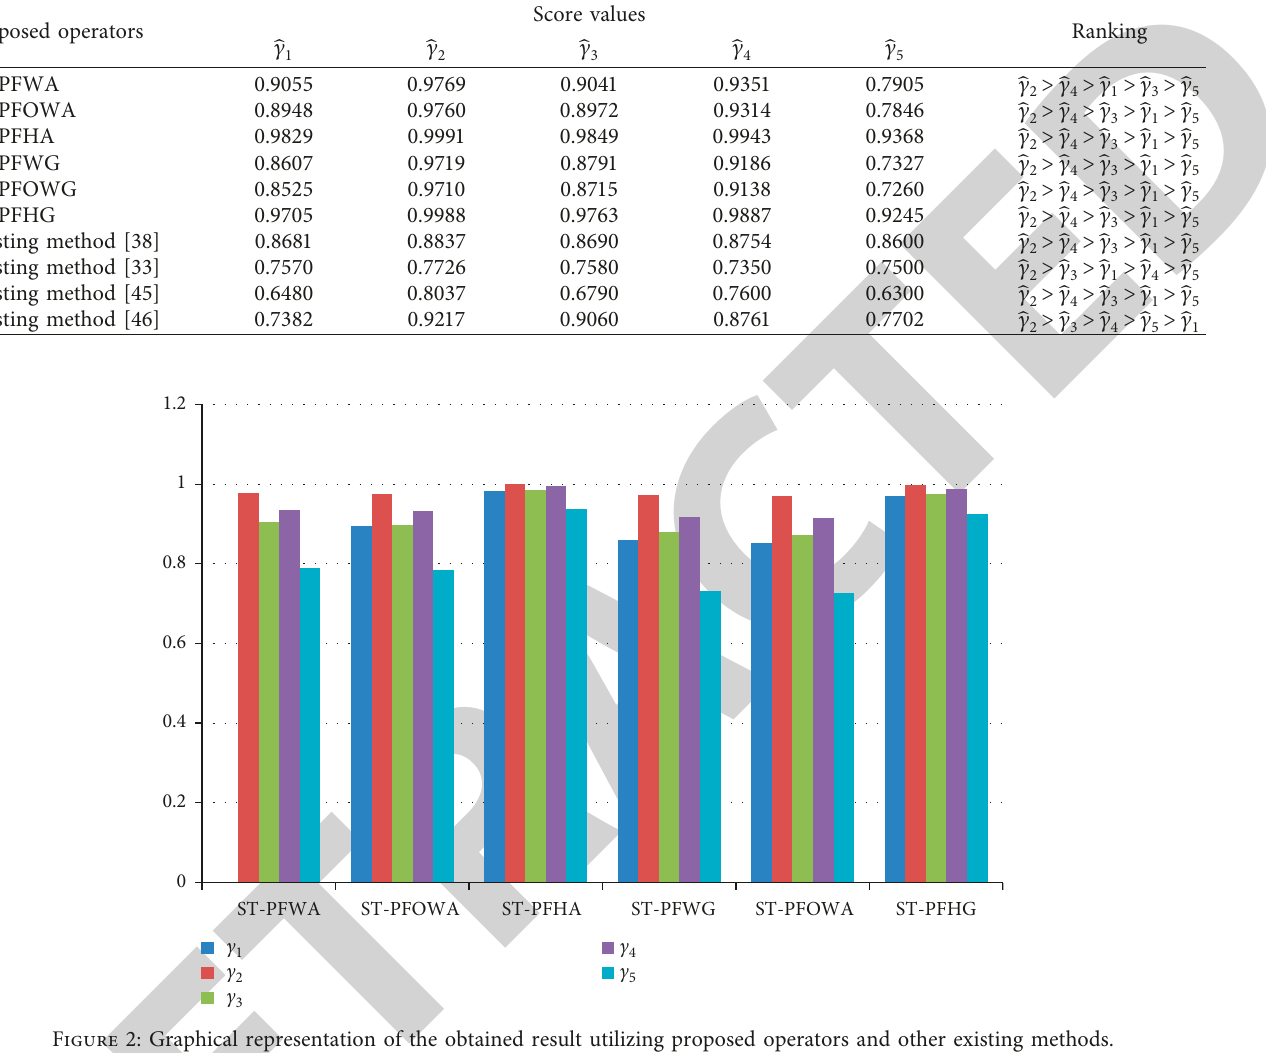
Table 6: Score values and ranking of the proposed operators and existing operators.